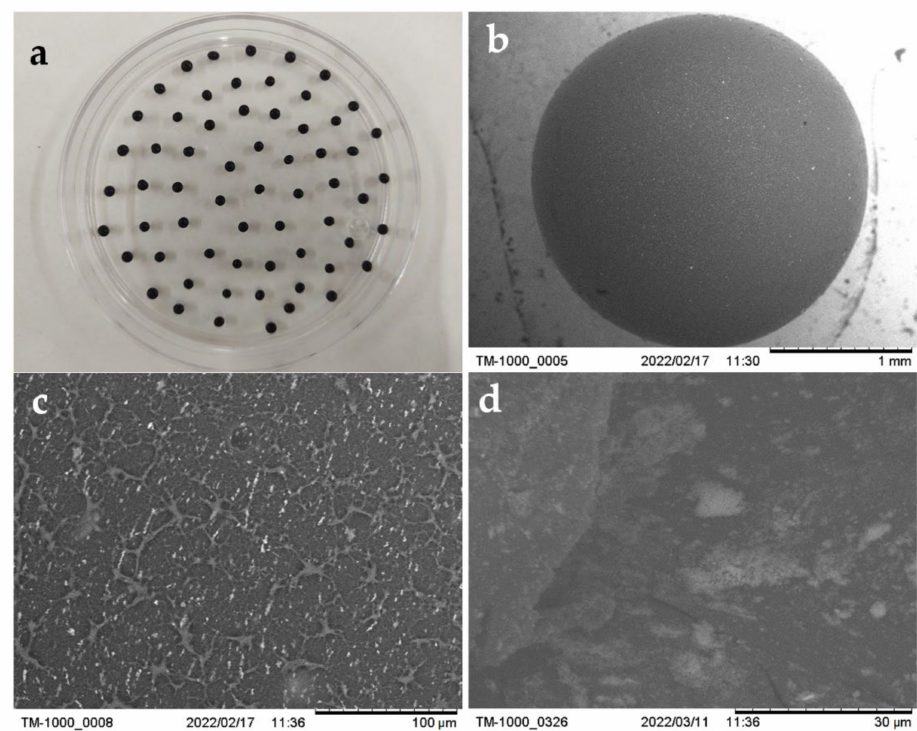
Figure 2. Images of ChM beads obtained ( a ) with a digital camera. ( b – d ) with a scanning electron microscope